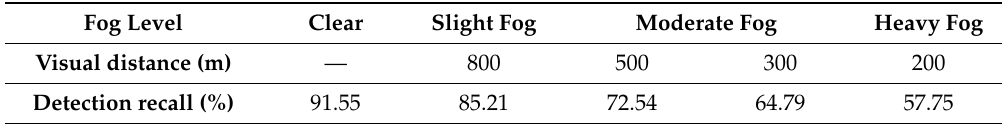
Table 3. Detection recall of Faster R-CNN in di ff erent visual